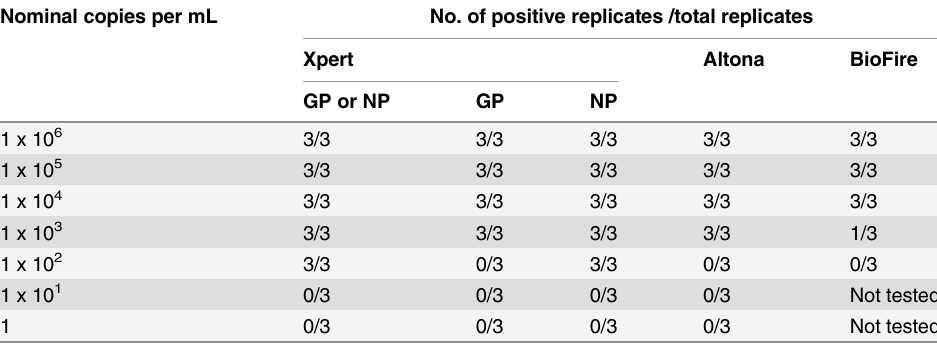
Table 2. Range finding analysis of the Xpert 1 Ebola Assay, Altona RealStar 1 Ebolavirus RT-PCR Kit 1.0, and BioFire Defense LLC FilmArray Biothreat-E Test 1 using Inactivated EBOV Yambuku-